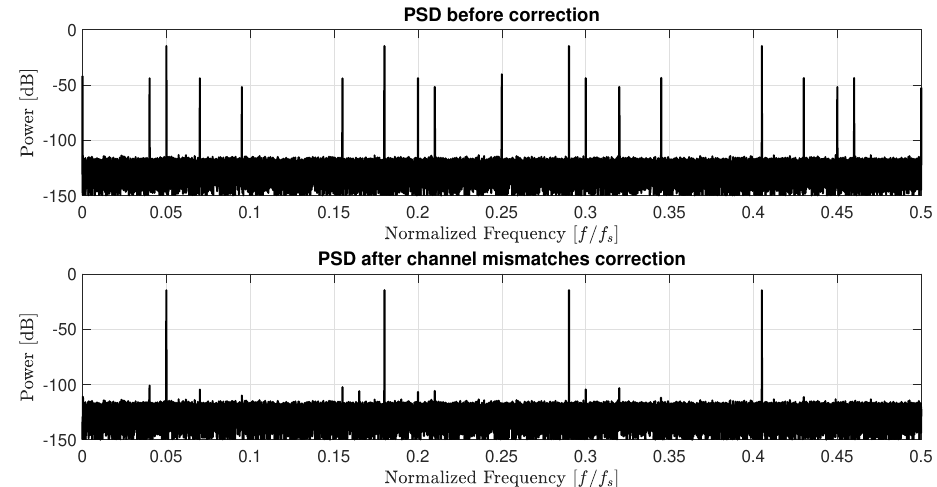
Figure 6. The four channel TIADC output spectrum for the multi-tone sinusoidal input signal before and after calibration.